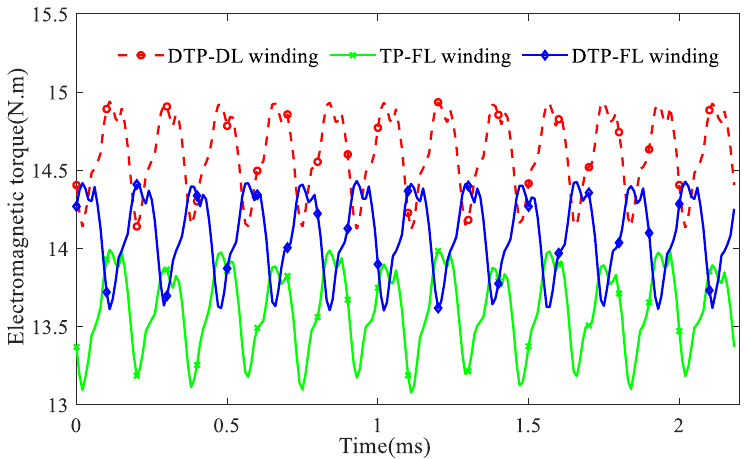
Figure 22. Transient electromagnetic torque for multi-phase multi-layer